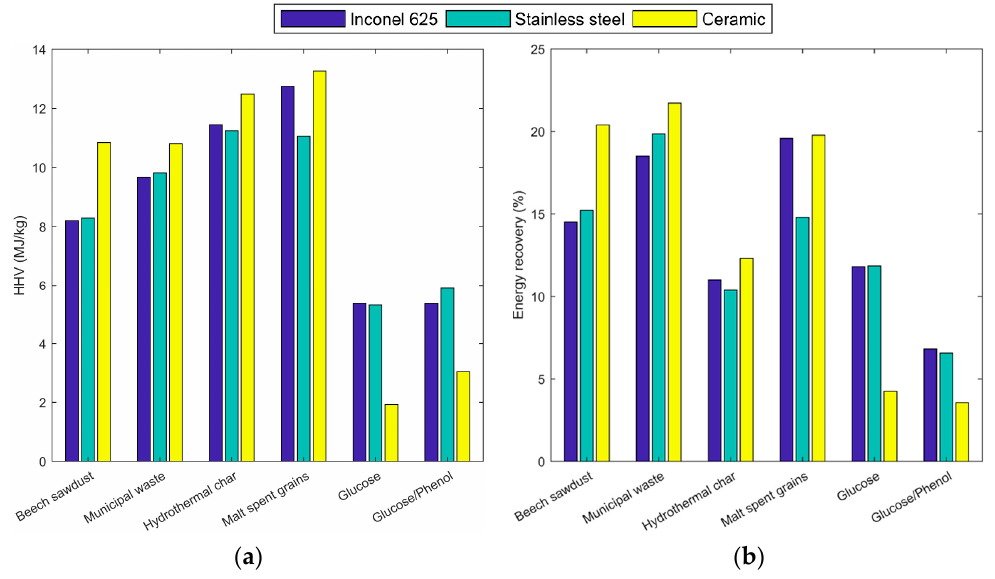
Figure 3. ( a ) Higher heating value of the produced gas. ( b ) Energy recovery in the gas phase for the considered biomasses and model compounds.